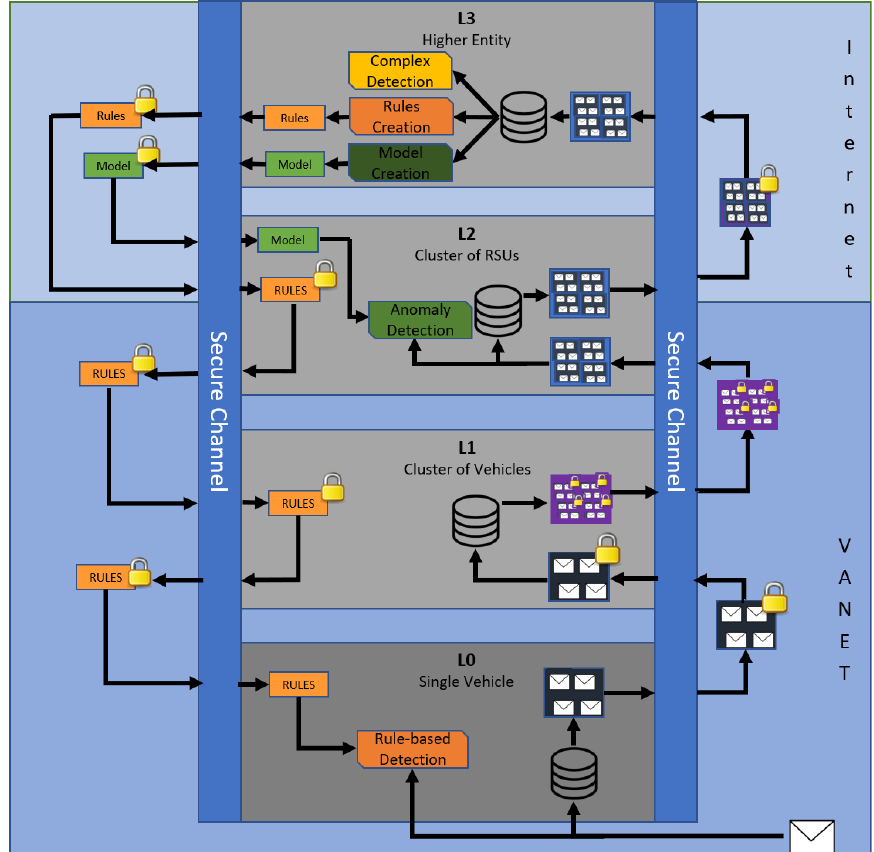
Figure 3. Intelligent Hierarchical IDS Security Framework